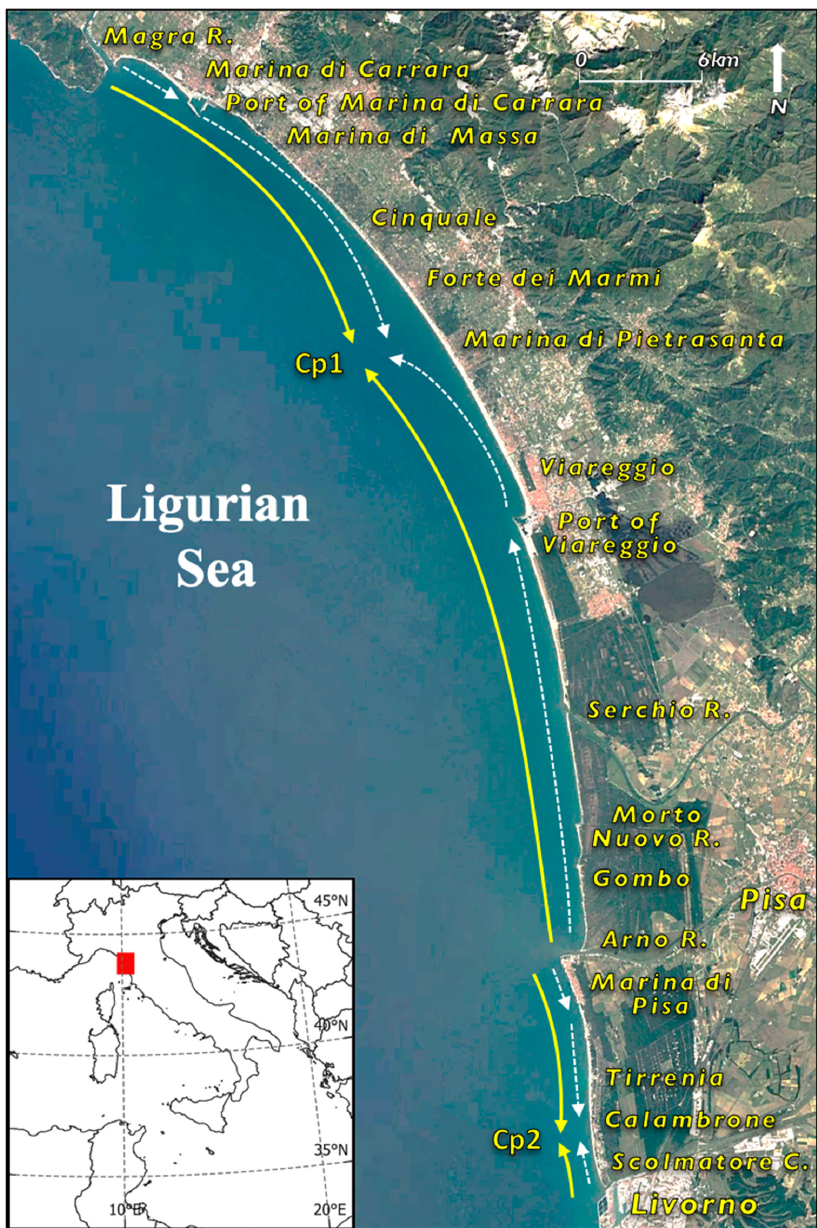
Figure 1. Map of the study area. The white dashed lines identify the anthropogenic sub-cells within the Northern Tuscany littoral cell. The yellow lines represent the direction of the longshore drifts, which generate two convergence zones at Marina di Pietrasanta (Cp1) and at Calambrone (Cp2). The background image has been retrieved from the Google Earth